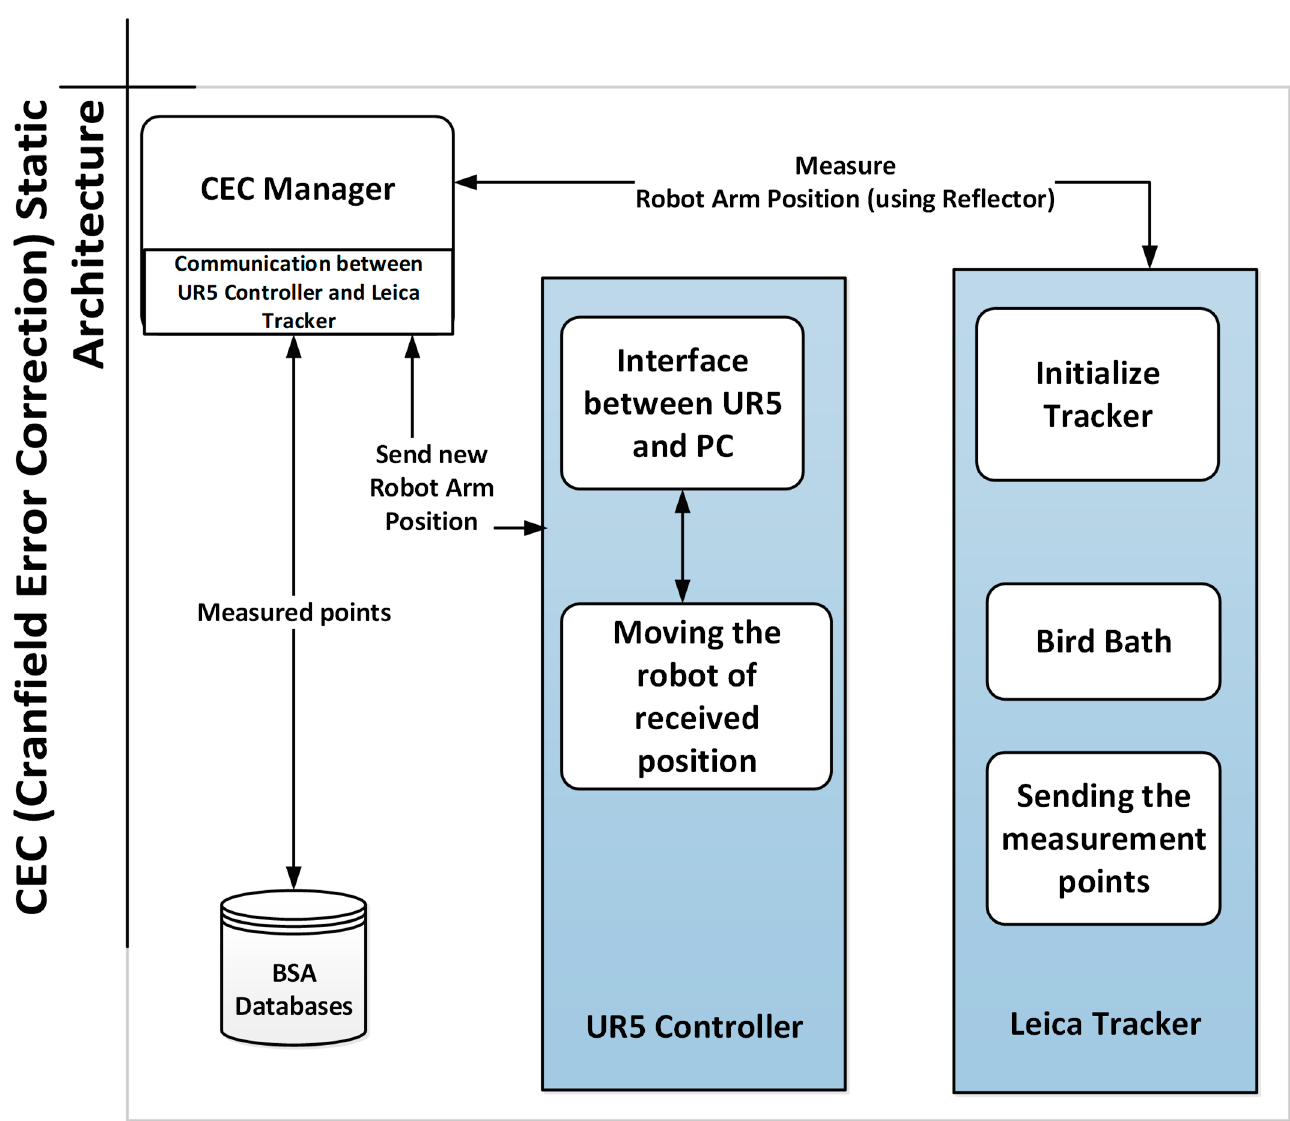
Figure 2. CEC system